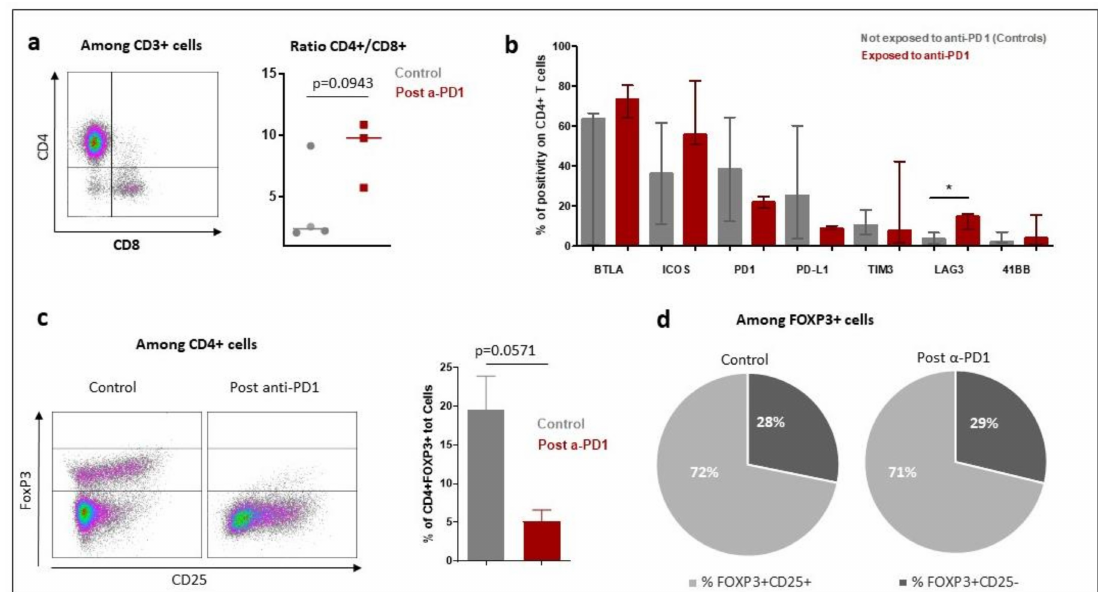
Figure 5. Characteristics of tumor microenvironment CD4+ T-cell population in patients with Hodgkin lymphoma exposed to anti-PD-1 and naïve to anti-PD-1 (control patients) by fresh tumor microenvironment cells analysis (part B study). The characteristics of the CD4+ lymphocytes in the tumor microenvironment were compared between patients who received immunotherapy (post α -PD-1 patients; n = 3) and controls patients not exposed to anti-PD-1 (control patients; n = 4). ( a ): Overview of CD4+ and CD8+ T lymphocytes distribution in patients exposed to anti-PD-1 and control patients not exposed to anti-PD-1. The bar indicates the median of the values. (1) p -value was determined with a Mann–Whitney test with Welch’s correction. ( b ): Expression of immune checkpoint markers on CD4+ T cell surfaces of tumor microenvironment. The rectangle indicates the median of values and the bar the interquartile range. p -value was determined with a Mann–Whitney test and Welch’s correction. * Indicates the median positive expression of LAG-3 was found significantly higher in exposed to anti-PD-1 samples compared to controls (15.05 [IQR:17.91–10.65] versus 3.84 [IQR 1.87–6.57]; p = 0.0376). Other markers did not significantly vary between controls and exposed to anti-PD-1 samples. ( c ): Proportion of FoxP3+ Tregs cells among CD4+ T-cells. In the left part of the figure are two representative dot plots showing FoxP3+ T regulatory cells, one from a control patient and another from post-anti-PD-1 treated patient. On the right part of the figure is shown the bars chart of relative proportion of CD4+ FoxP3+ regulatory T cells. p -value was determined with a Mann–Whitney test and Welch’s correction. ( d ): Distribution of activated and non-activated regulatory T cells in tumor